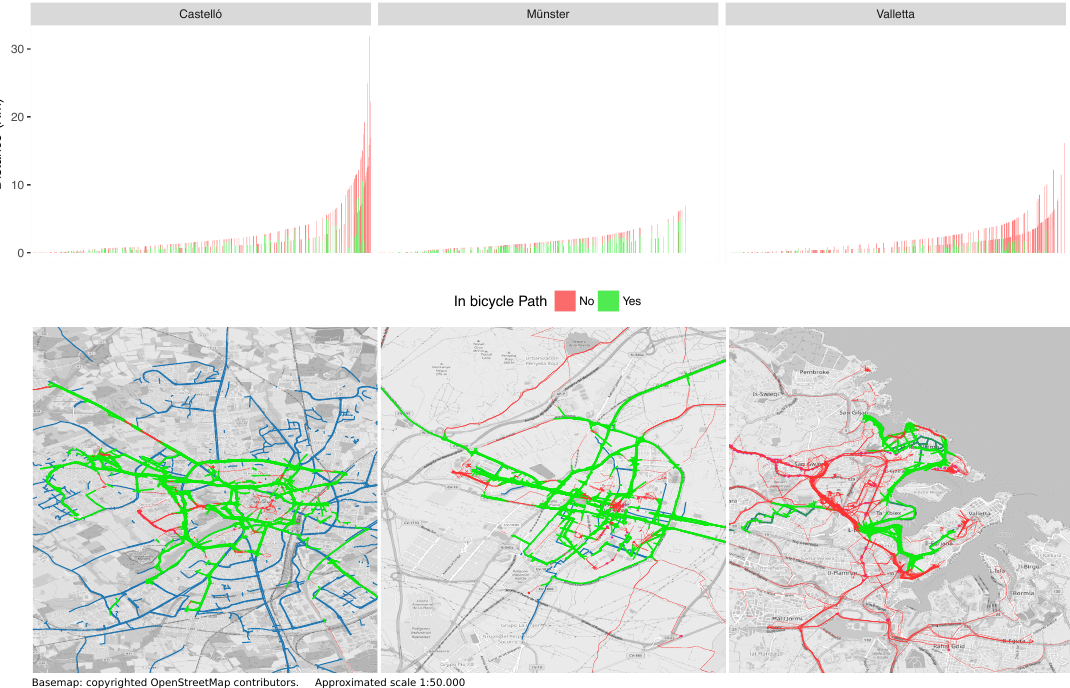
Figure 9. Cycled distance using bicycle